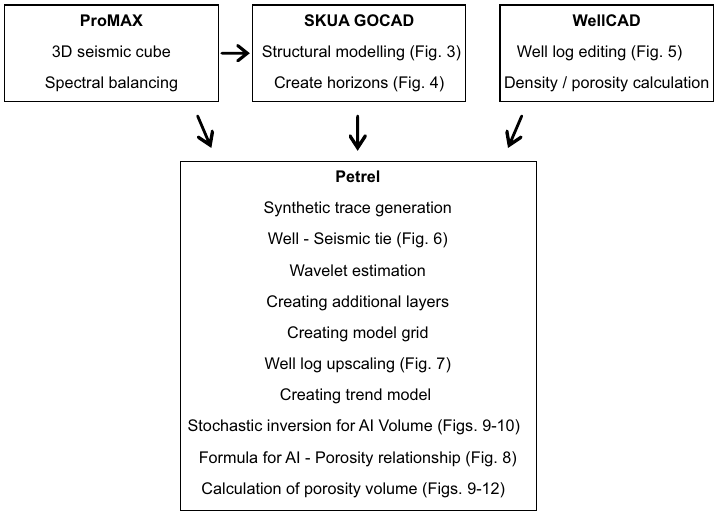
Fig. 2 Workflow utilized to perform the full-stack stochastic seismic amplitude inversion with references to the corresponding illustrations